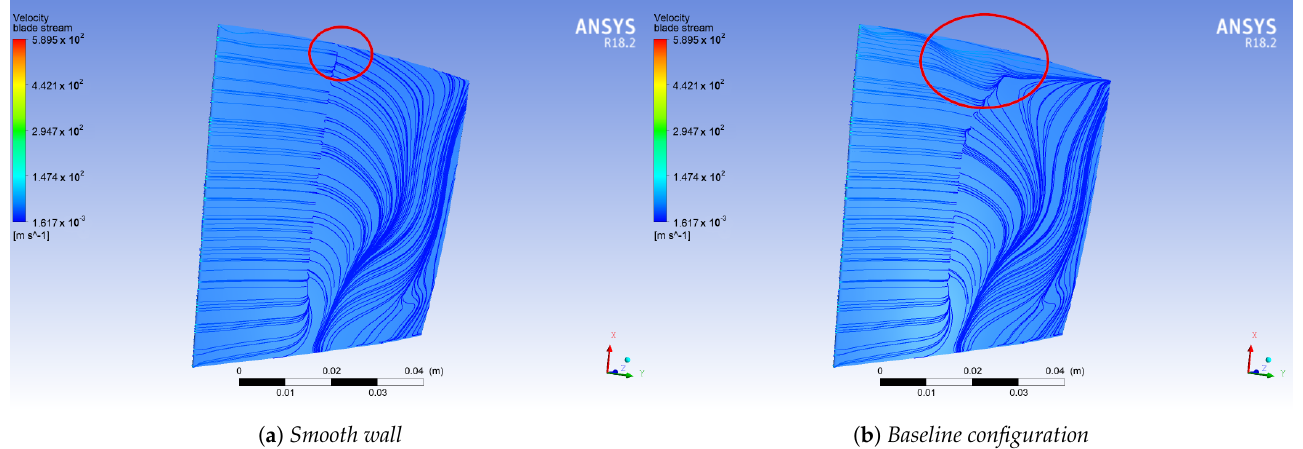
Figure 15. Surface streamlines at the near-stall point of the smooth wall